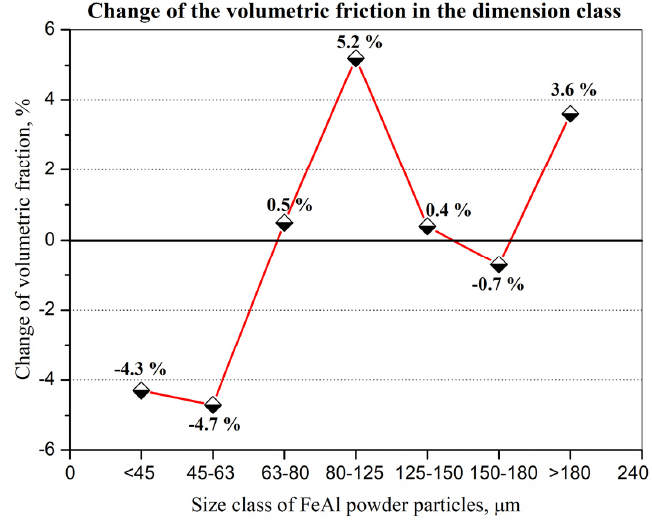
Figure 13. Percentage change in volume fraction in a specific size class of FeAl powder particles sprayed with D-gun into water as compared to as-received FeAl powder.